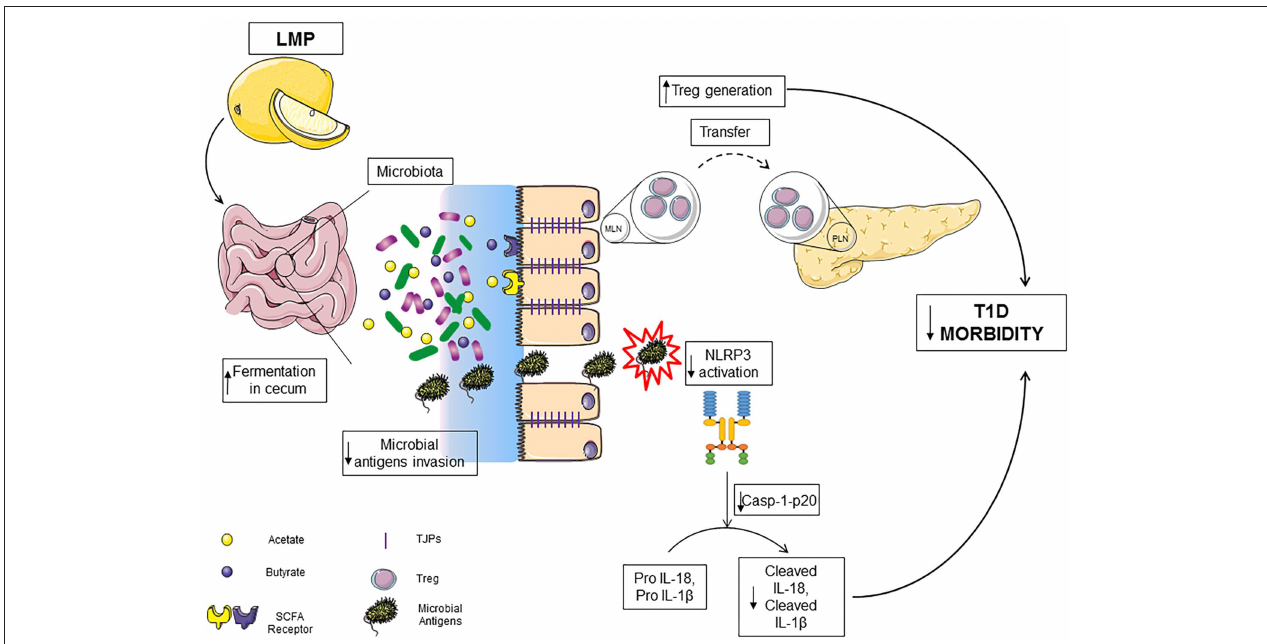
FIGURE 8 | LMP supplementation limits T1D by modulating gut homeostasis in NOD mice. LMP supplementation induces gut microbiota homeostasis to increase the production of SCFA in caecum and normalizes caecal barrier function by upregulating the expression of tight junction proteins, which results in decreased microbial antigen translocation, surpressed NLRP3 inflammasome activation and enhanced frequencies of Foxp3 + Treg in caecum and